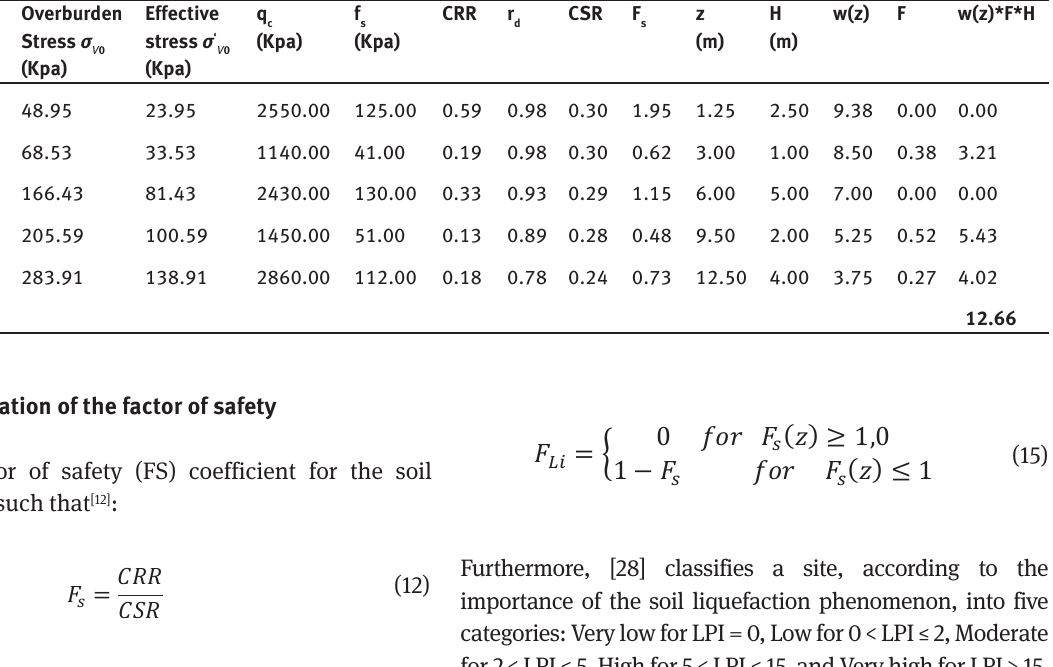
Table 1: Computation of LPI for peak horizontal ground acceleration of 0.3 g corresponding to M Depth Average (m) Density (KN/m 3 )